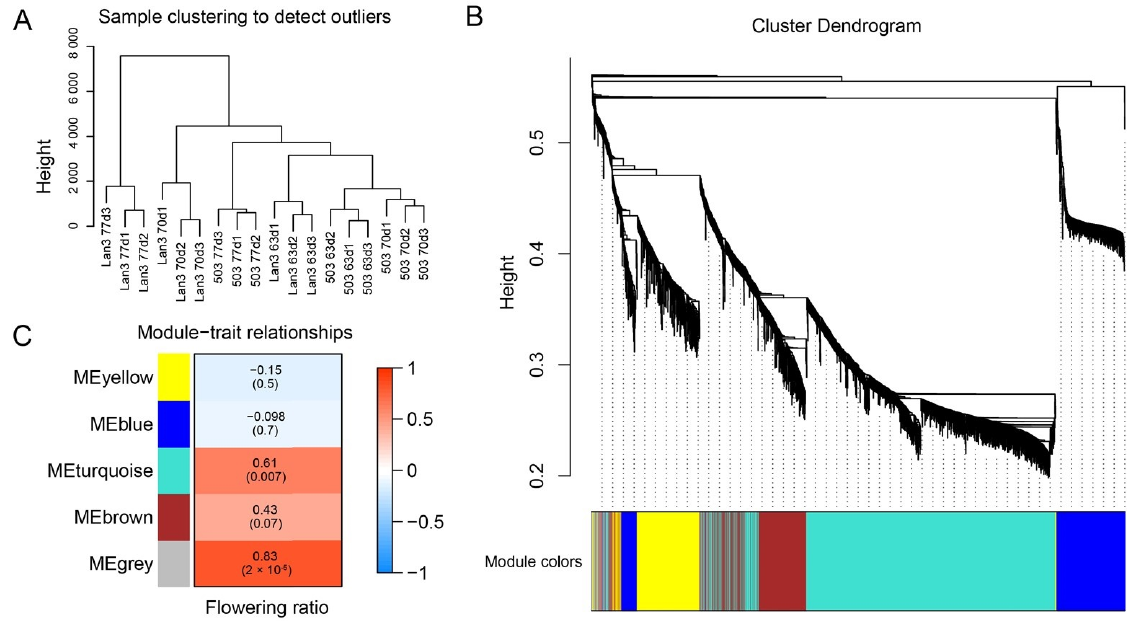
Figure 2. Mesh of the model used for the FEM calculation of the J-integral for CRB specimens. Figure 4. Weighted gene co-expression network analysis (WGCNA) of key genes related to flowering in V. sativa . ( A ) Hierarchical clustering plot of all samples. ( B ) Cluster dendrogram of all the DEGs between Lan3 and 503. Each of the genes is represented by a tree leaf, while each of the five modules is represented by a major tree branch. ( C ) Relationships between each module and the flowering ratio. The left panel shows five modules (yellow, blue, turquoise, brown, and gray); the right panel is a color scale for module trait correlations and ranges from − 1 to